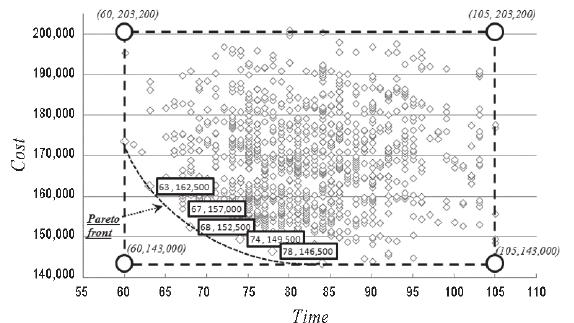
Fig. 8. 1,000 highly ranked populations and the Pareto front in the original coordinate